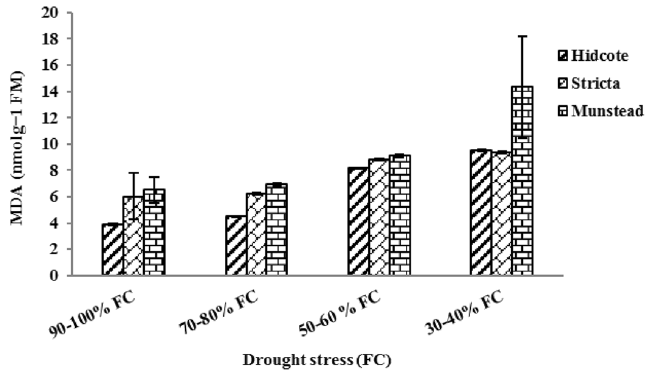
Figure 8. The effect of drought stress on MDA content in different lavender genotypes.